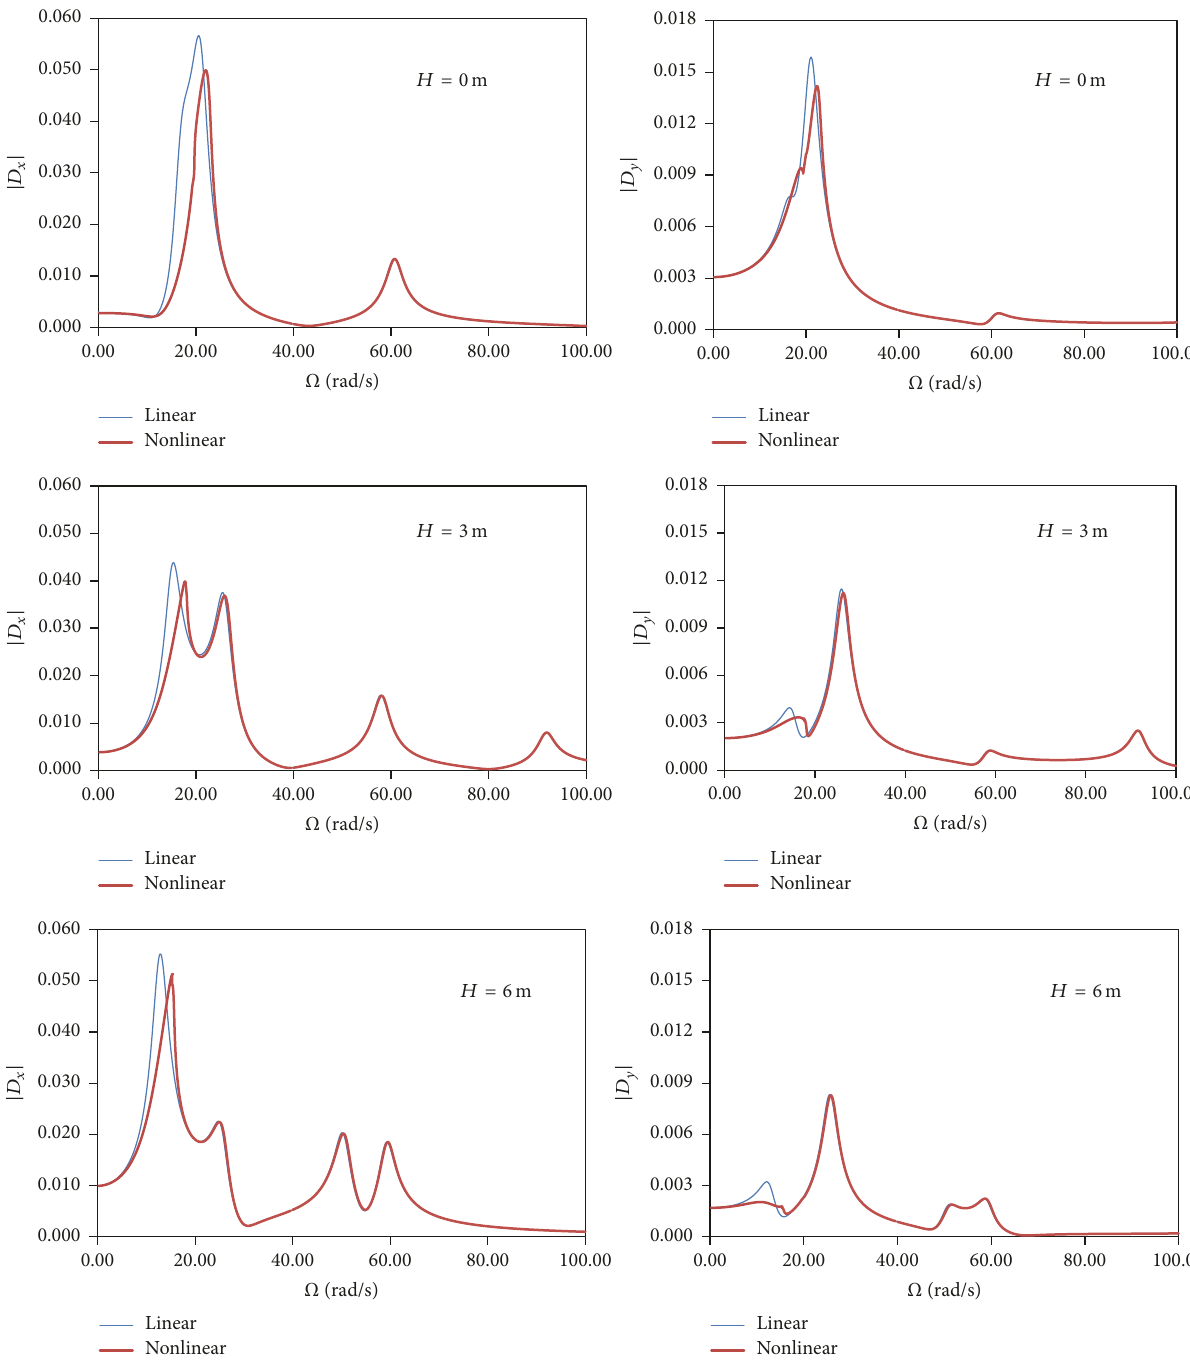
Figure 13: Influence of the roof height on the nonlinear response of the frame under horizontal and vertical excitation. 𝐴 𝑥 = 0.8𝑔 and 𝐴 𝑦 = 0.667𝐴 𝑥